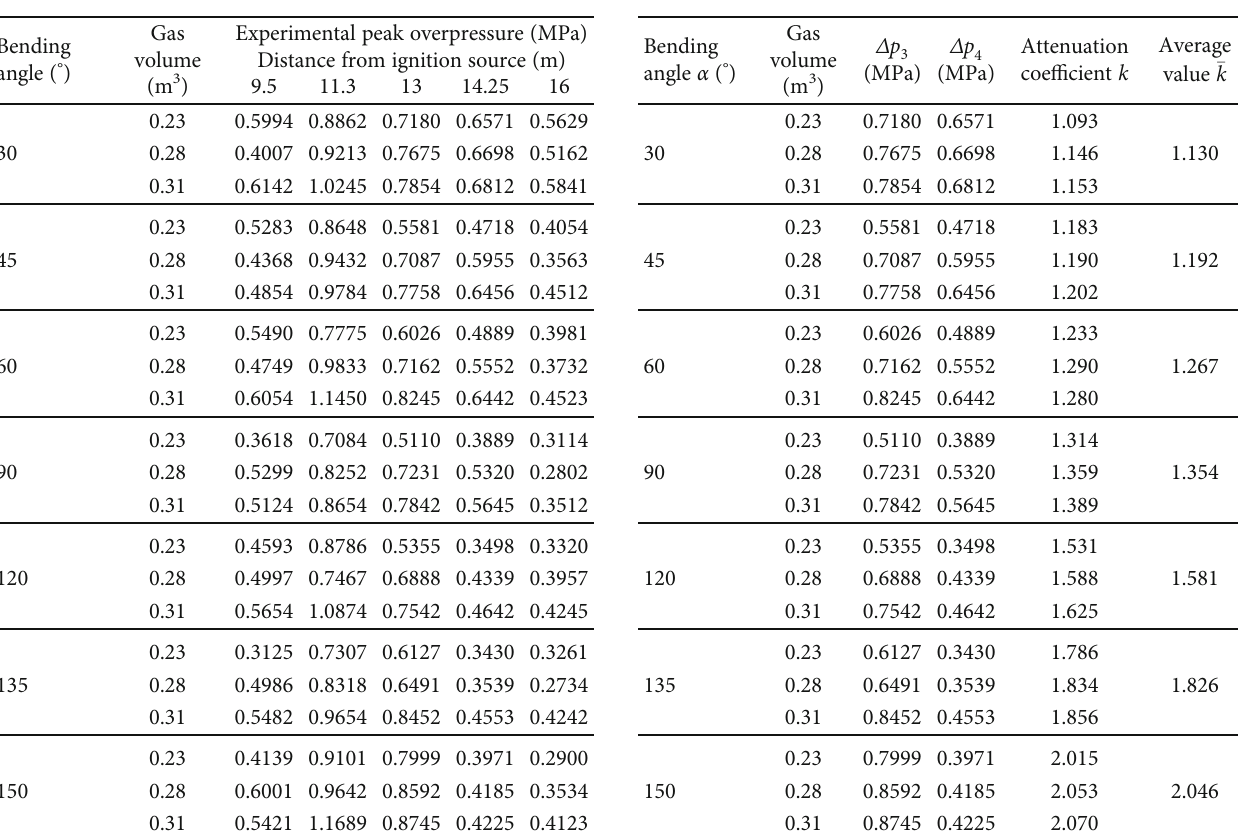
Table 2: Experimental peak overpressure of gas explosion and distance in bend pipes.